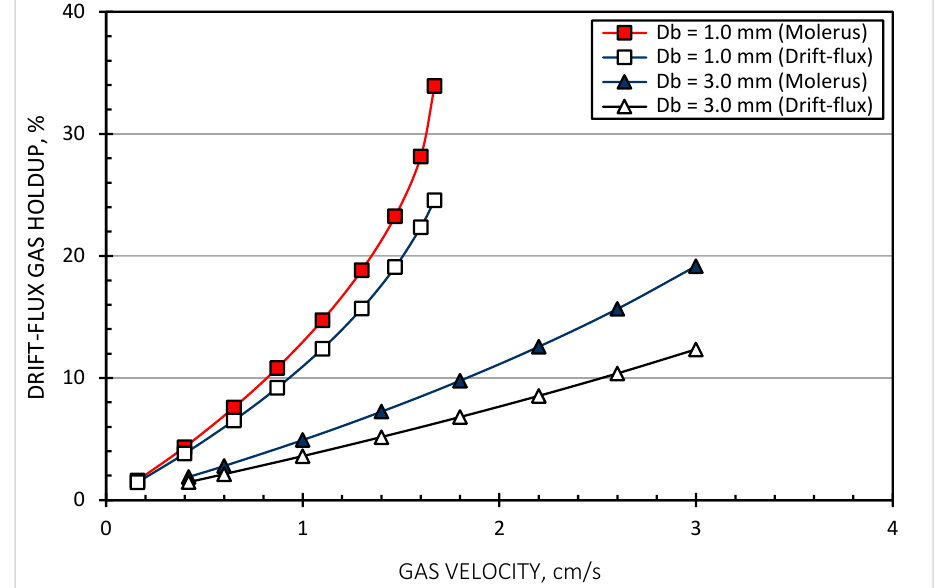
Figure 4. Gas holdup model predictions vs. gas velocity for selected bubble sizes.